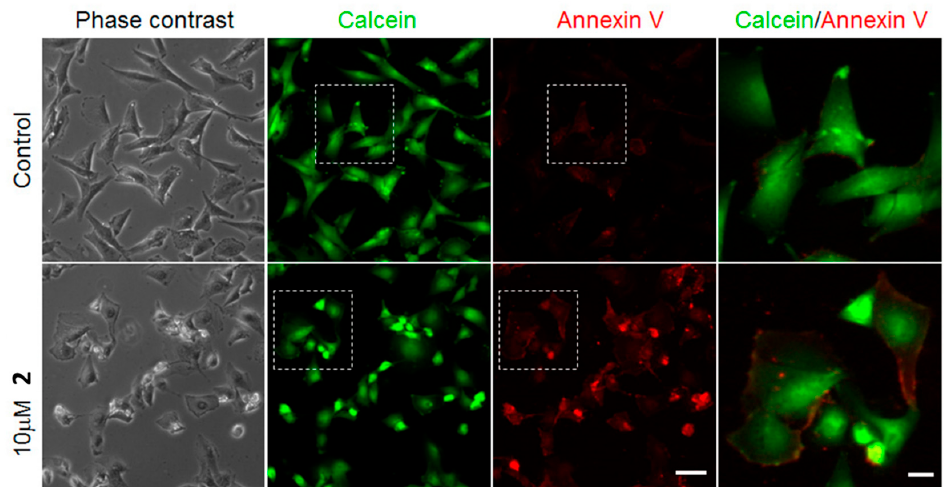
Figure 6. U87 glioma cells undergo apoptosis upon 48 h treatment with 10 µM of 2 . Cells in the early stages of apoptosis show calcein (green)/Annexin V-Cy3 (red) double labeling. Scale bars: 50 µm; 20 µm for inserts.